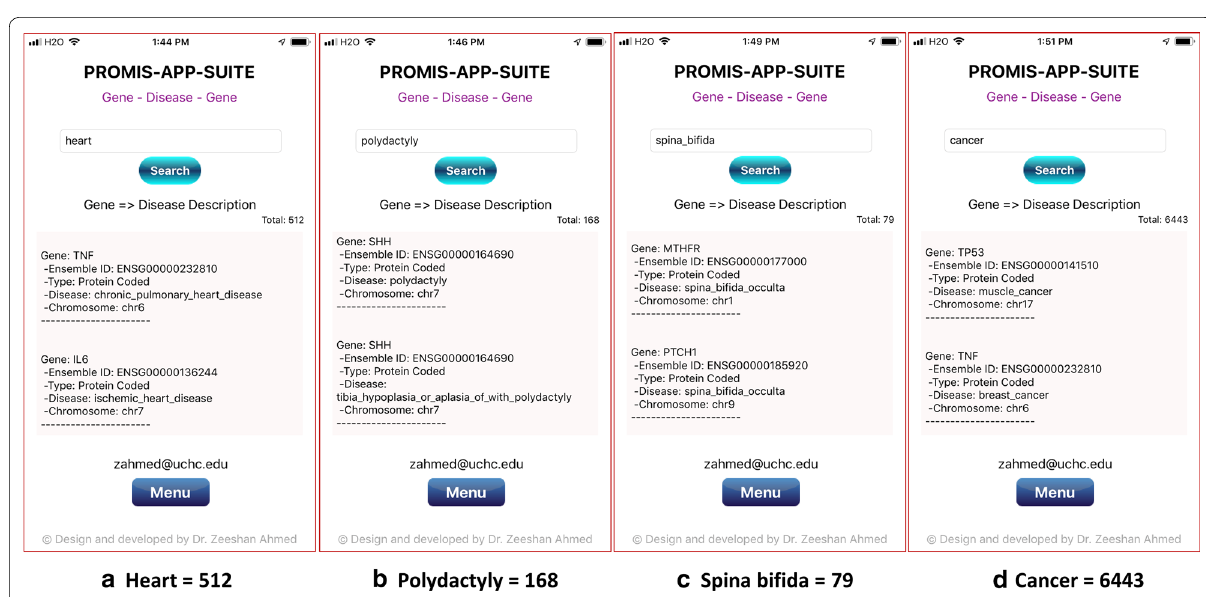
presenting gene-disease associations for most common genetic diseases include, 117 results for Thalassemia, 49 results for Down Syndrome, 91 results for Cystic Fibrosis, 18 results for Sickle Cell Anemia, 16